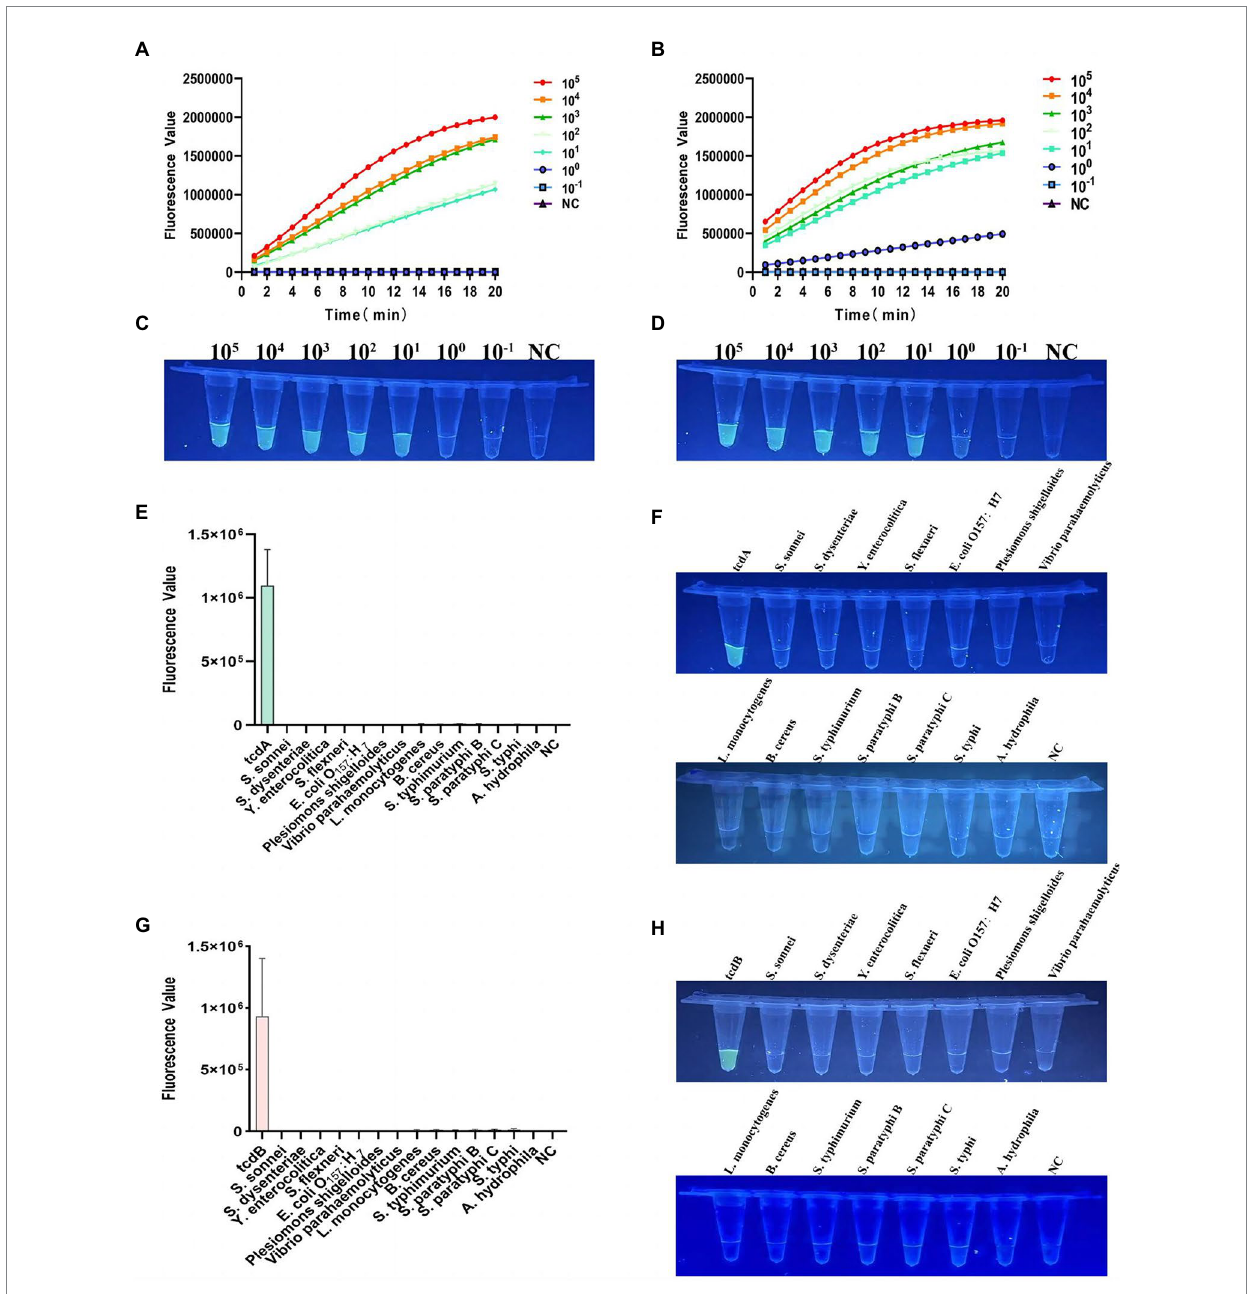
FIGURE 4 Verification of sensitivity and specificity of the multiplex RPA-Cas12a-fluorometric assay. (A) Sensitivity of tcdA gene after multiplex RPA amplification of the plasmid DNA with gradient dilution, fluorescence graphs. (B) Sensitivity of tcdB gene after multiplex RPA amplification of the plasmid DNA with gradient dilution, fluorescence graphs. (C) Sensitivity of tcdA gene after multiplex RPA amplification of the plasmid DNA with gradient dilution, endpoint Blueprint. (D) Sensitivity of tcdB gene after multiplex RPA amplification of the plasmid DNA with gradient dilution, endpoint blueprint. (E) Specificity of multiplex RPA amplification of tcdA gene. (F) The end-point fluorescence of tcdA gene after irradiation with a UV flashlight. (G) Specificity of multiplex RPA amplification of tcdB gene. (H) The end-point fluorescence of tcdB gene after irradiation with a UV flashlight. NC, negative control. All experiments were repeated at least 3